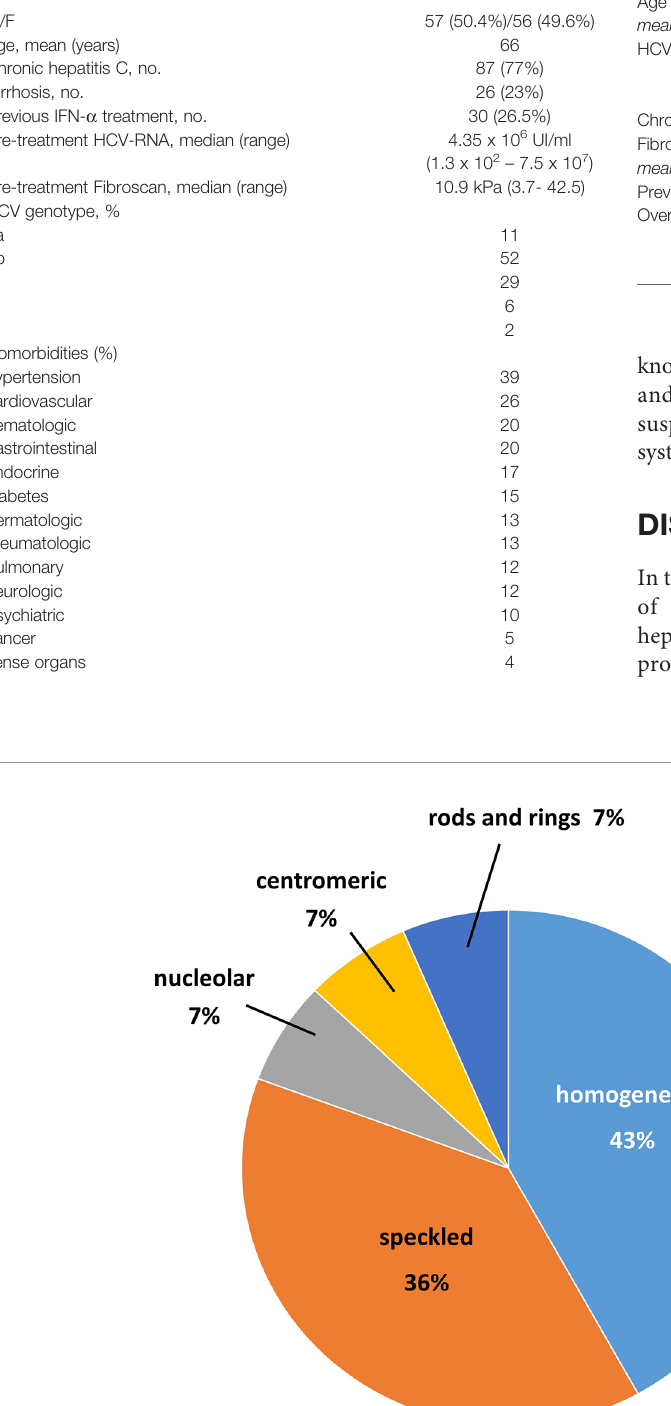
TABLE 1 | Baseline characteristics of HCV-infected patients undergoing DAA treatment. Patients, no.